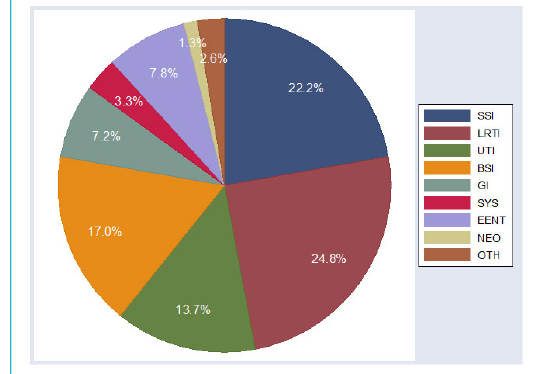
Figure 1: Distribution of healthcare-associated infections (n = 153) – multicentre point prevalence survey, Switzerland 2016.BSI = bloodstream infection; EENT = ear/eye/nose/throat infection; GI = gastrointestinal infection; LRTI = lower respiratory tract infection; NEO = neonatal infection; OTH = other infection; SSI = surgical site infection; SYS = systemic infection; UTI = urinary tract infec- tion